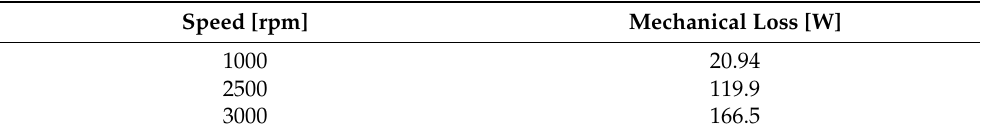
Table 3. Mechanical losses in the no-load condition.